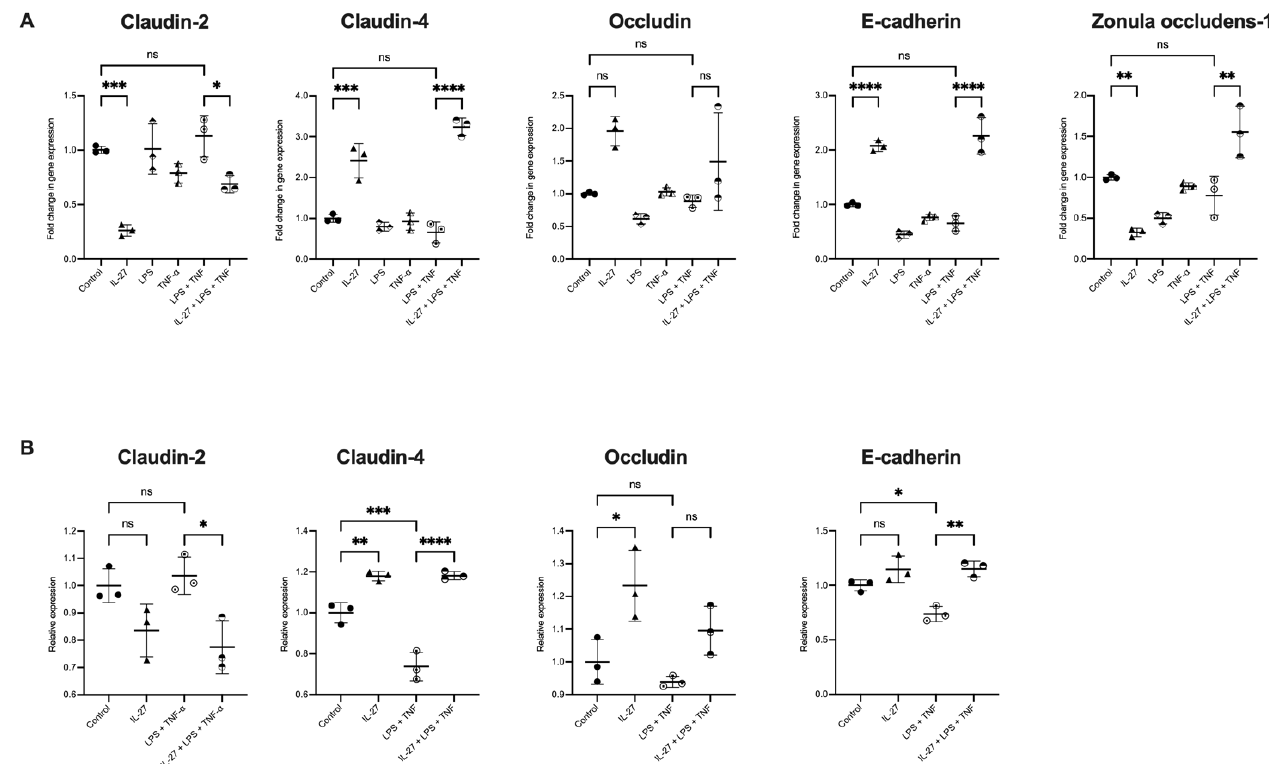
Figure 3. IL-27 effect on human gastrointestinal colonic organoid gene and protein expression in an organoid model of IBD. Human colonic organoids stimulated with rhIL-27 (100 ng/mL), LPS (500 ng/mL), TNF- ⍺ (100 ng/mL) and combinations of the three as indicated. ( A ) Expression of epithelial barrier function genes compared to unstimulated controls. ( B ) Protein expression of epithelial barrier junction proteins as determined by Western blotting. Gene and protein expression normalised to GAPDH; n = 3 individual patient-derived organoids, with 3 technical replicates/experiment, presented as mean ± SD. Statistical analysis with one-way ANOVA with Bonferroni correction. * p < 0.05, ** p < 0.01, *** p < 0.001 and **** p < 0.0001; ns = not significant.